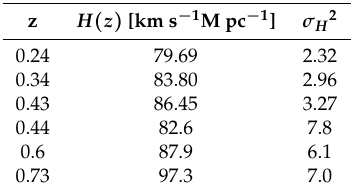
Table 2. BAO sample data from